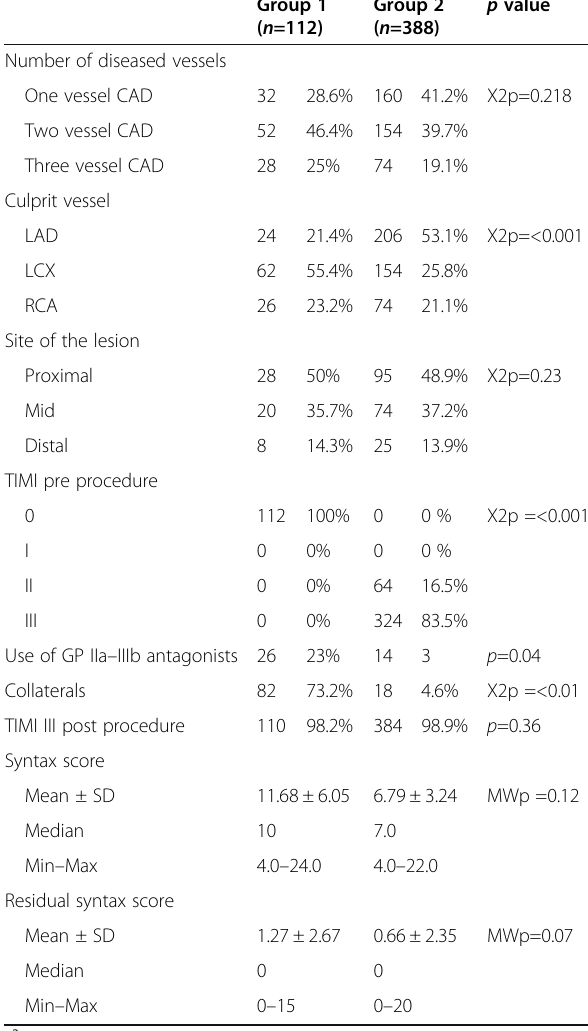
Table 4 Procedural characteristics of the studied